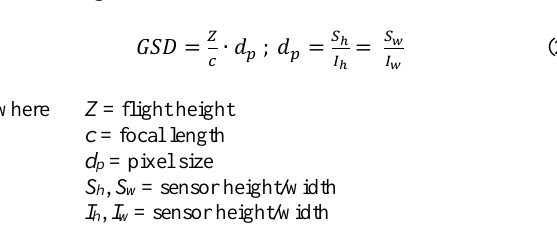
Figure 1. Example of nadiral (left) and oblique (right) images of the panel with the ice